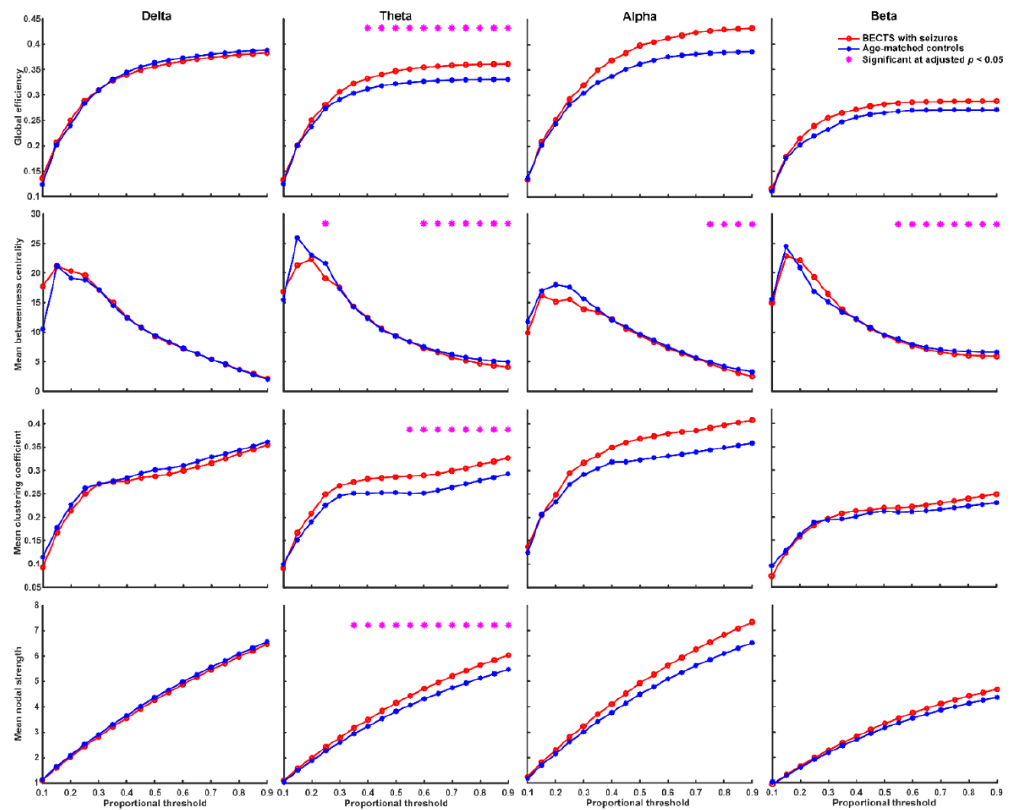
Figure 2. Graph-based functional connectivity indices between BECTS with seizures and age-matched controls as each proportional threshold at each frequency band. BECTS children with seizures have significantly higher global efficiency ( ≥ 40% proportional threshold), mean clustering coefficient ( ≥ 55% proportional threshold), and mean nodal strength ( ≥ 35% proportional threshold) in the theta band compared to age-matched controls (* adjusted p < 0.05). BECTS children with seizures have lower mean betweenness centrality in theta, alpha, and beta bands mostly at high thresholds compared to age ‐ matched controls.